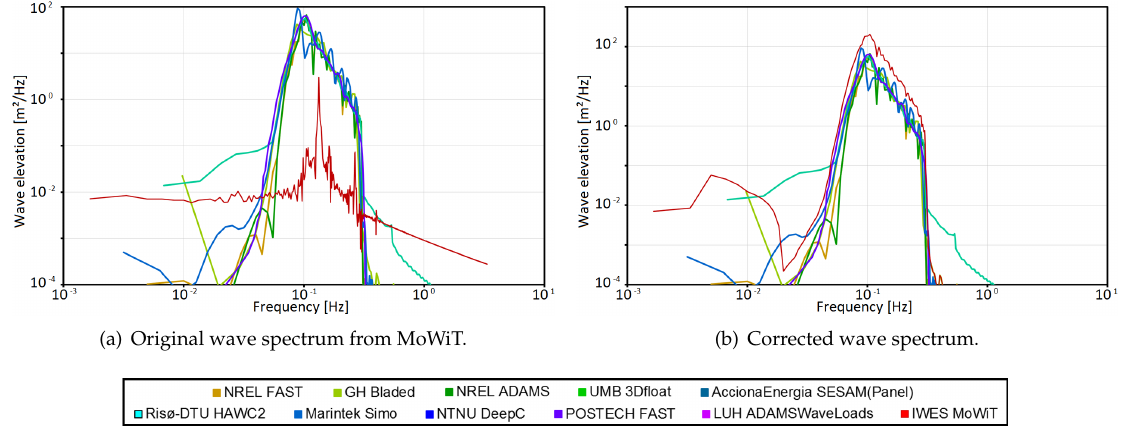
Figure 20. Wave power spectra for LC 5.3 in comparison.